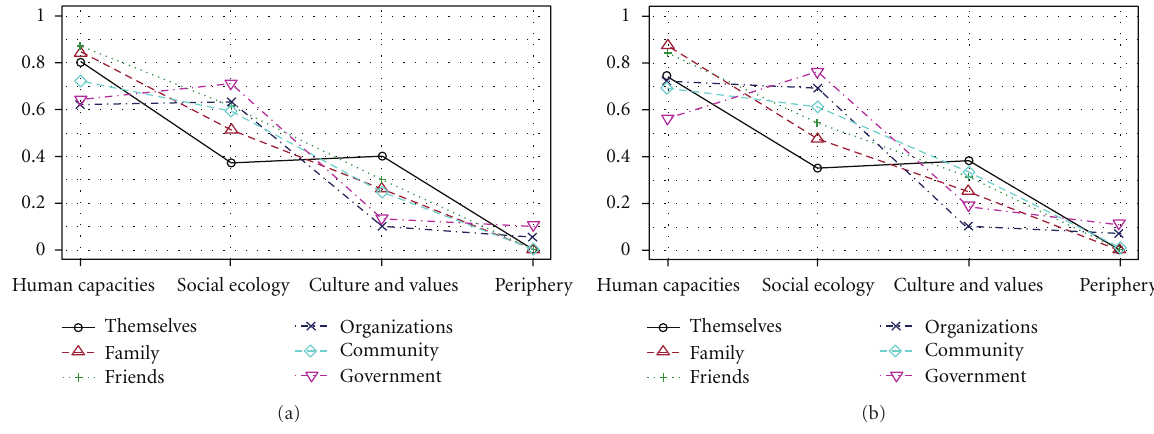
Figure 2: Proportion of formerly recruited (a) and non-recruited (b) youth’s answers per resource domain and